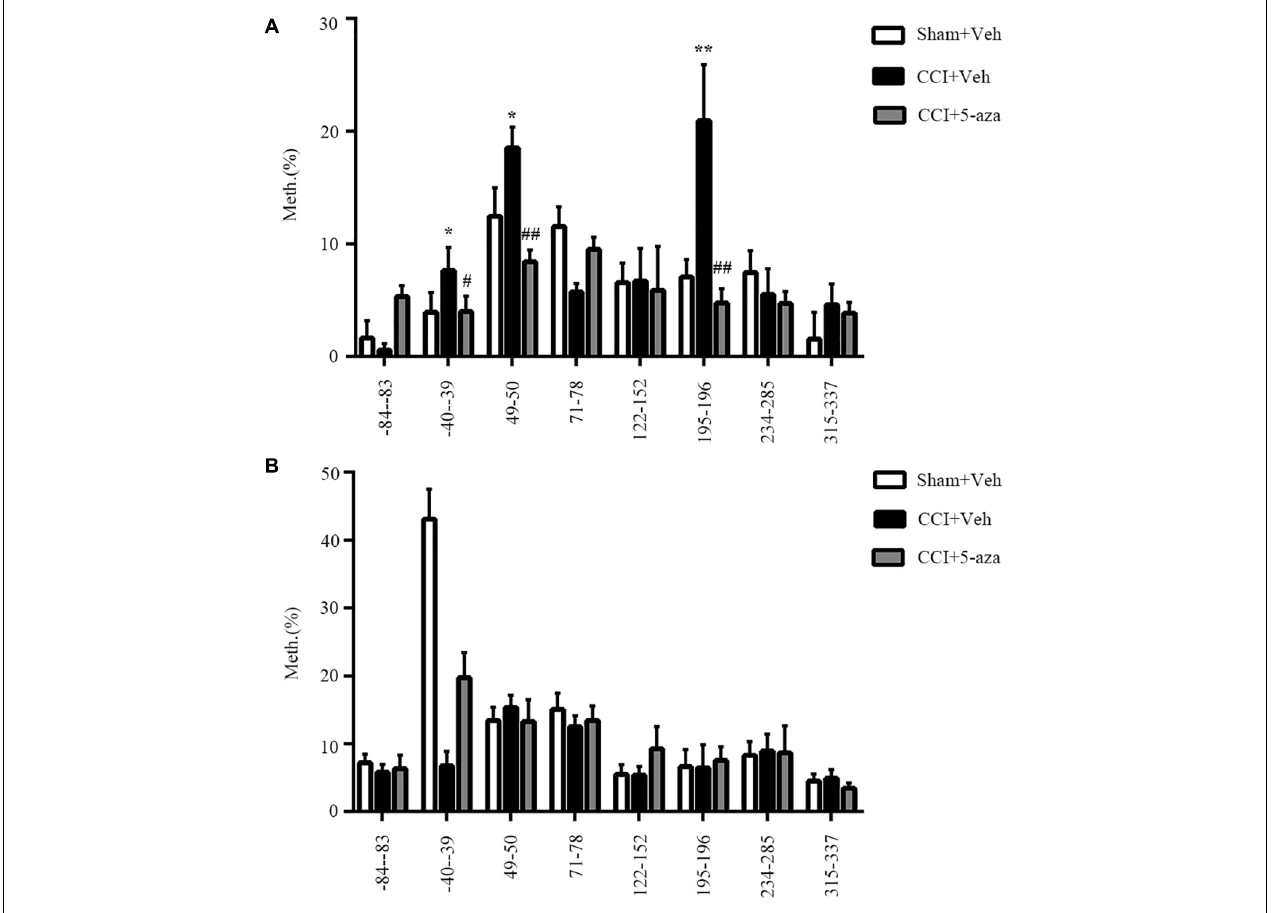
FIGURE 3 | Methylation status of the Oprm1 gene proximal promoter after nerve injury. (A,B) Methylation of the eight regions in the 5 (cid:48) –flanking regions of the Oprm1 gene (from –85 to +634 bp) in the injured DRG (A) and the ipsilateral spinal cord (B) . n = 3 biological repeats (18 mice)/group in DRG, n = 3 biological repeats (3 mice)/group in the spinal cord. One-way ANOVA followed by post hoc Tukey test. F group (2, 6) = 15.47, 4.506, 21.62, 16.11, 0.06245, 23.99, 1.814, and 2.291, respectively, for the 8 sites in the DRG. F group (2, 6) = 0.6497, 81.25, 0.6808, 1.156, 3.006, 0.1352, 0.03783, and 1.614, respectively, for the 8 sites in the SC. * p < 0.05, ** p < 0.01 versus the sham plus vehicle group; # p < 0.05, ## p < 0.01 versus the CCI plus vehicle